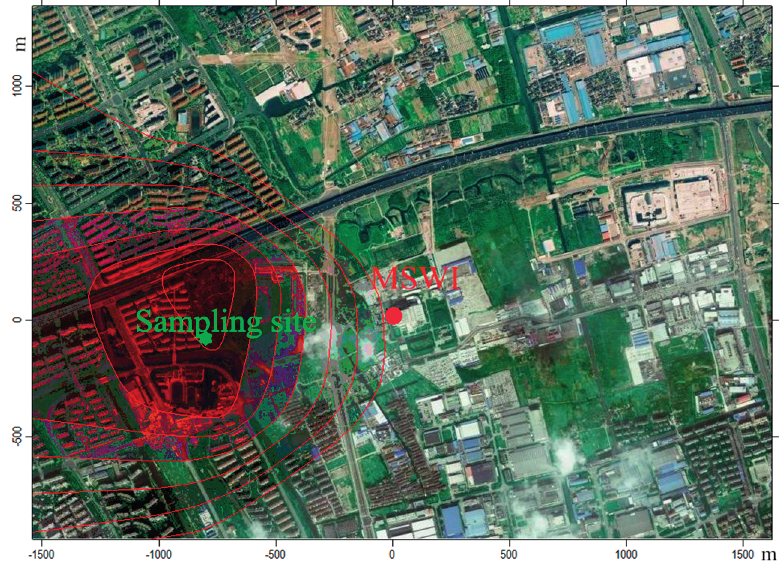
Figure 1. The concentration distribution of particulate matter (PM) from the municipal solid waste incineration (MSWI) calculated by AERMOD (atmospheric dispersion modeling) (prevailing wind direction: east, average wind speed: 3.4 m/s and temperature: 21 °C) and the location of the sampling